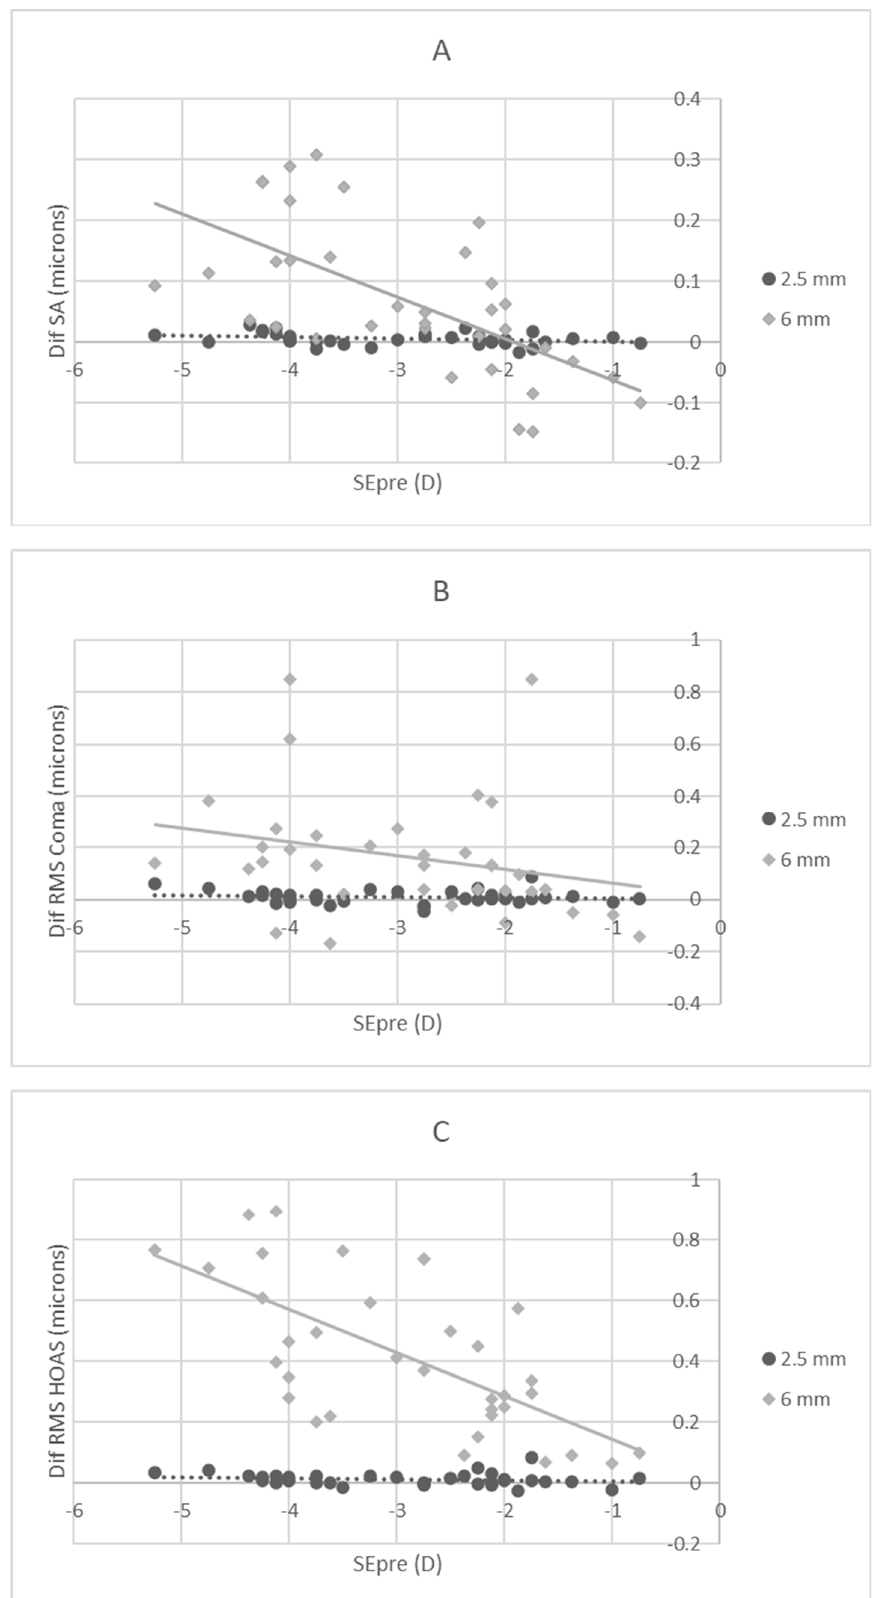
Figure 7. ( A – C ) Dispersion diagrams for 2.5 mm pupil size. Correlation between the preoperative spherical equivalent and the difference between preoperative and postoperative values of SA ( A ) and RMS coma ( B ) and HOAS RMS ( C ).